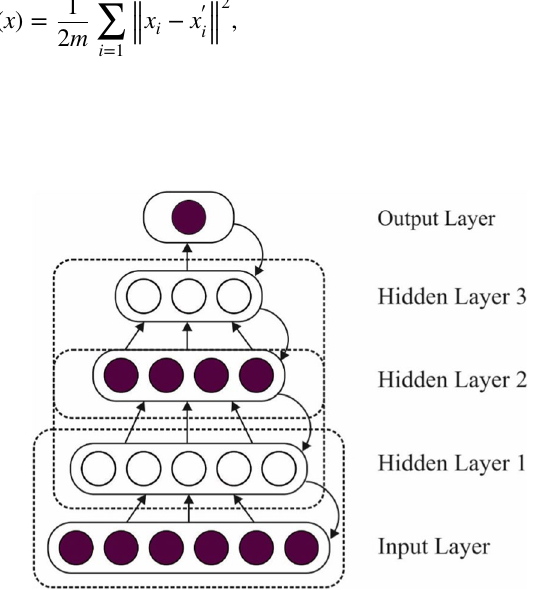
Fig. 3 Structure of